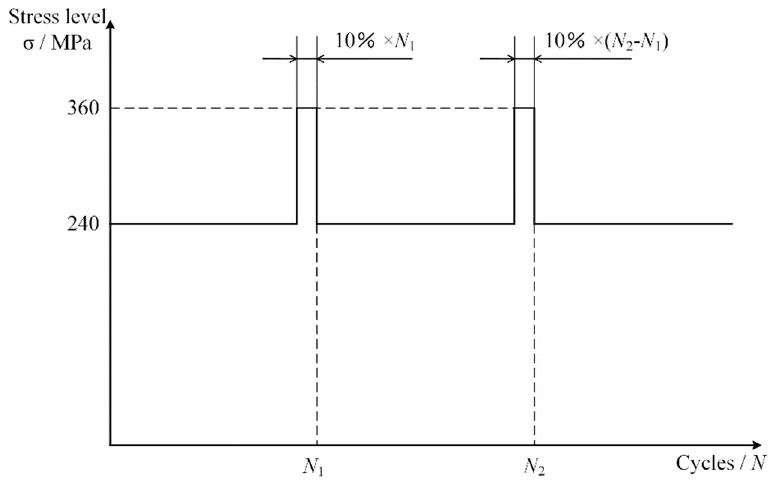
Figure 3. Schematic diagram of overload.